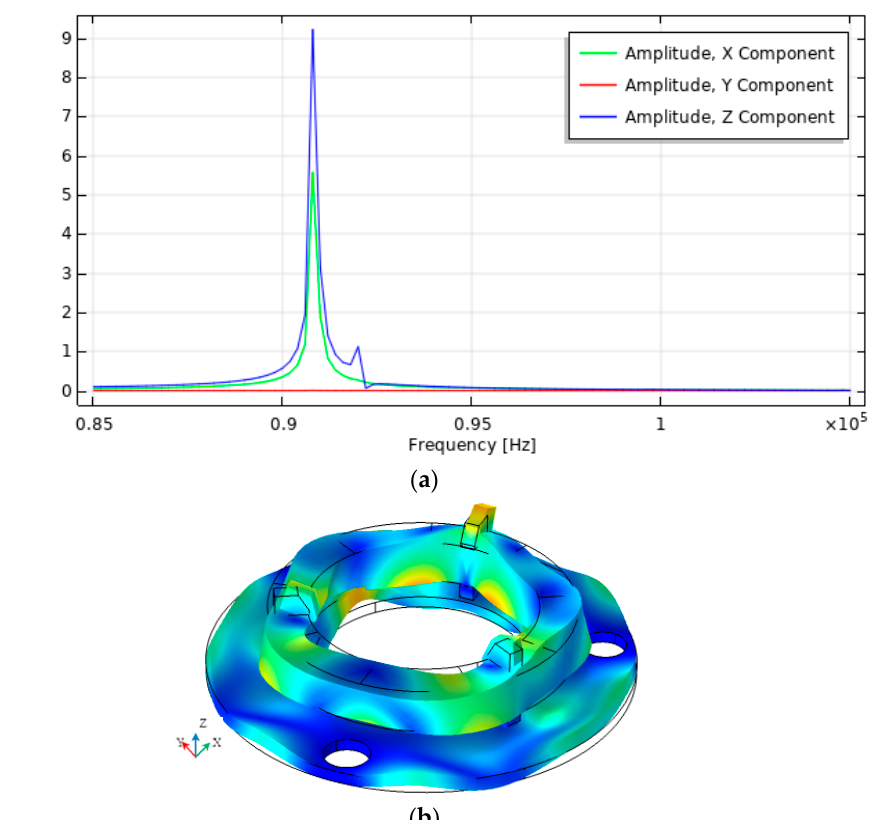
Figure 6. Results of harmonic response analysis when the top electrode is divided into nine equal segments. ( a ) amplitude-frequency characteristic; ( b ) vibration modes at 90.80 kHz.